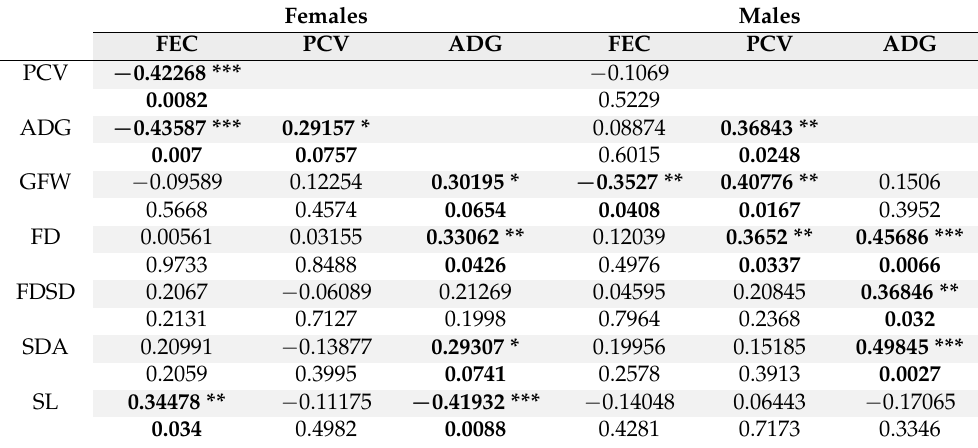
Table 4. Pearson’s correlation coefficients by sex (with p -values located below each correlation) between fecal egg count (FEC), packed-cell volume (PCV), and average daily gain (ADG) and grease- fleece weight (GFW), fiber diameter (FD), fiber diameter standard deviation (FDSD), and standard deviation along the fiber (SDA) and staple length (SL) in Rambouillet lambs. Lambs were sheared 4 months after an artificial H. contortus challenge, at approximately one year of age. Significant correlations and trends are bolded. Females